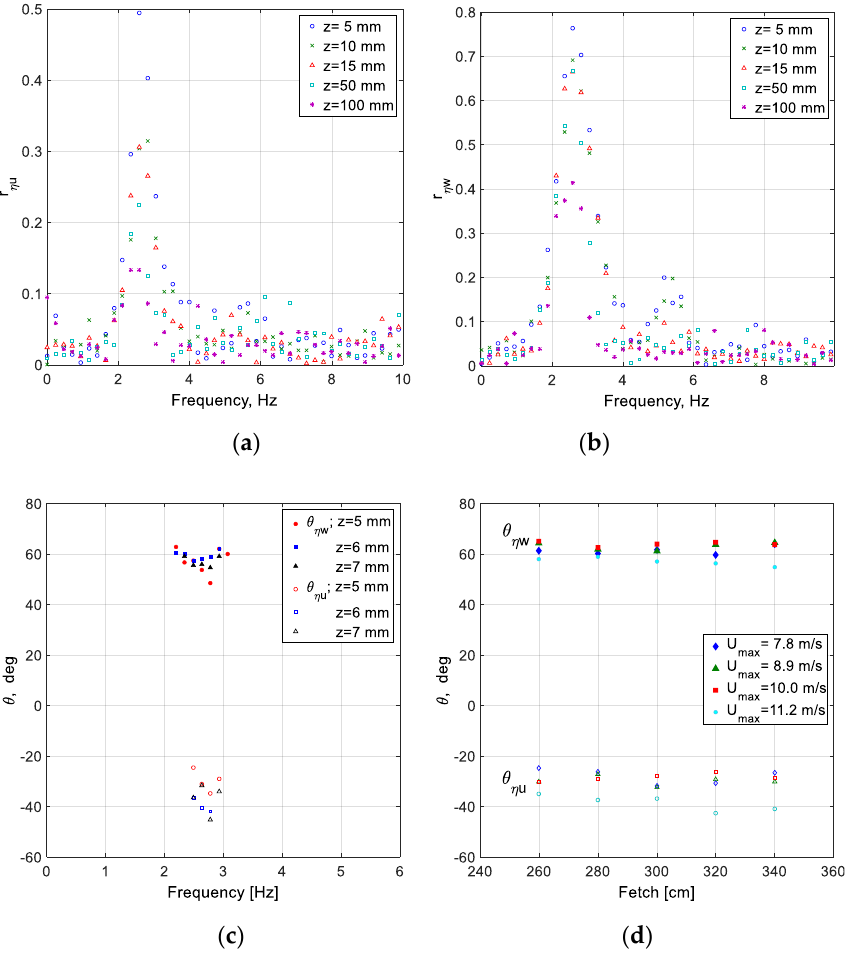
Figure 11. Characterization of wave-coherent air velocity fluctuations. ( a ) Cross-correlation coe ffi cients r η u at various elevations z above the highest crest at x = 260 cm and U max = 11.2 m / s; ( b ) as in ( a ) for r η w, x = 340 cm and U max = 11.2 m / s; ( c ) Phase shifts θ η u and θ η w in the vicinity of the peak frequency at x = 260 cm and U max = 11.2 m / s; ( d ) Phase shifts between the two velocity components and the surface elevation at the peak wind-wave frequency for various fetches and wind velocities.